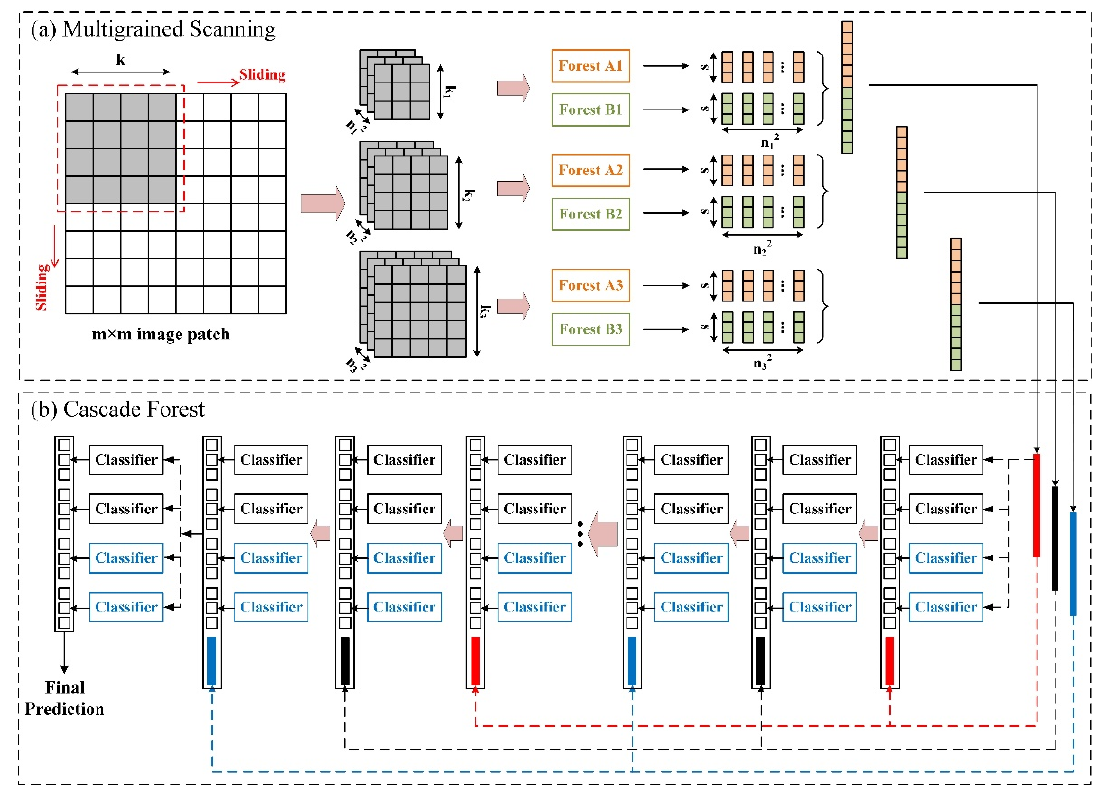
Figure 2. An illustration of the complete structure of gcForest. ( a ) Illustrates the procedure of multigrained scanning using three sliding window sizes. ( b ) Illustrates the structure of cascade forest. The ensemble classifier of each layer consists of several base classifiers.